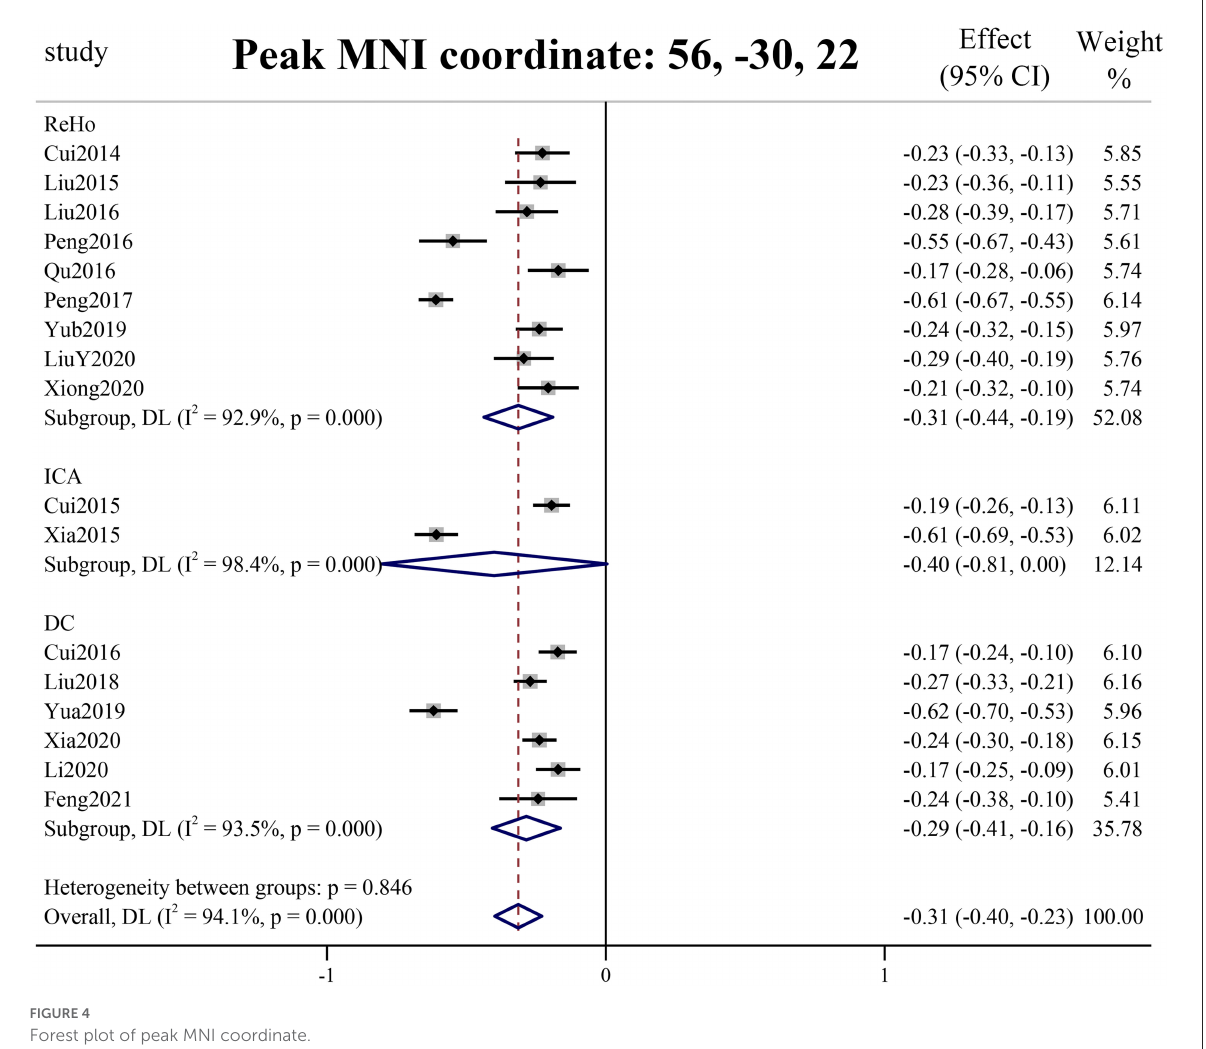
FIGURE4 Forest plot of peak MNI